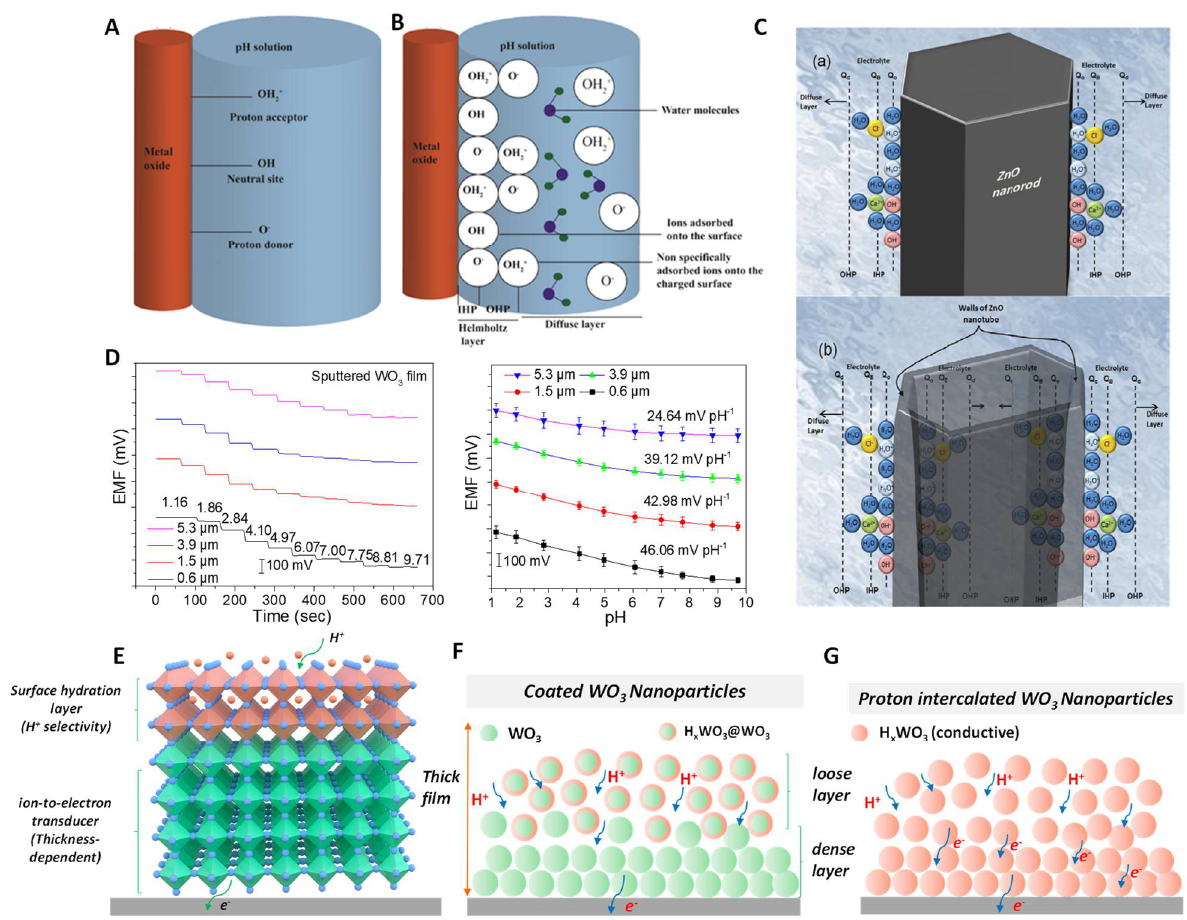
Figure 5. pH response mechanism for MO x . ( A ) Schematic representation of the site–binding theory to illustrate the response mechanism for MO x –based pH sensors. ( B ) The formation of the EDL structure on the surface of MO x . Reprinted with permission from [34], Copyright (2020) Elsevier. ( C ) Schematic illustration of the charge distribution at ZnO for ( a ) nanorod and ( b ) nanotube struc- tures. Reprinted with permission from [98], Copyright (2009) MDPI. ( D ) The thickness dependence of pH sensitivity for WO 3 . ( E ) pH response model according to typical SC–ISEs, including the surface hydration layer (H + recognition) and bulk ion–to–electron transducer layer. ( F ) Limited hydration for coated WO 3 nanoparticles. ( G ) Complete hydration by the proton intercalation of WO 3 . Reprinted with permission from [109], Copyright (2022) John Wiley and Sons publications.